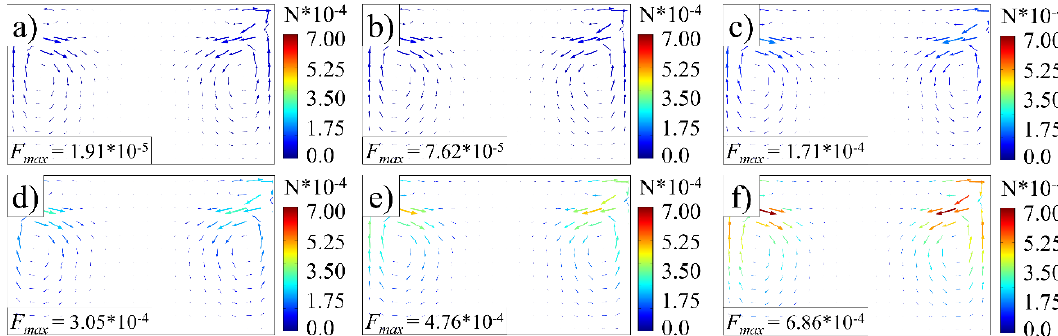
Figure 10. Total force on fluorescent particles at various amplitudes (ultrasonic frequency, 20 kHz):